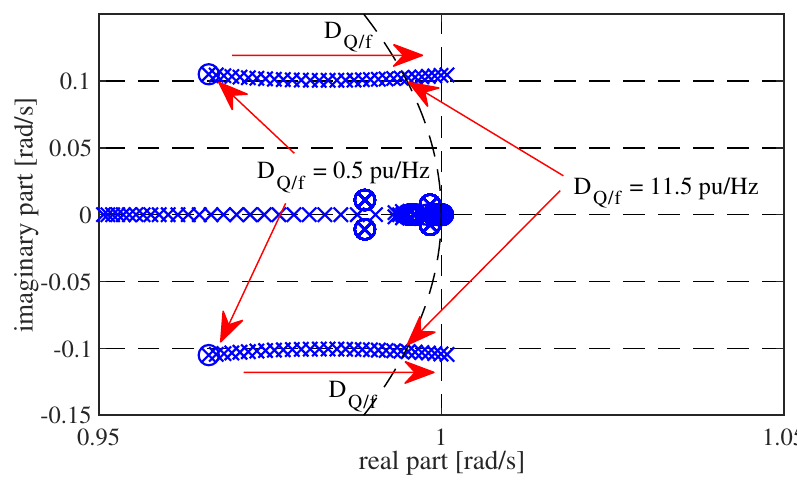
Figure 10. Zoom of the zero-pole map. Poles (crosses); zeros (circles).